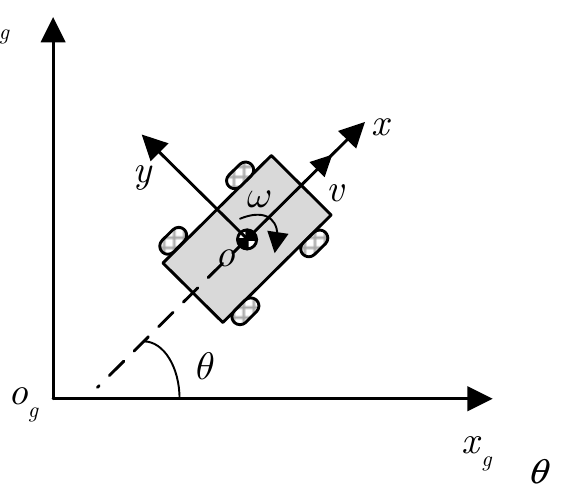
Figure 1. The four-wheel model and single-track model of the considered IWMD-MR. At the same time, the linear model reduces the amount of computation, convenient for the design of the controller and is conducive to the actual implementation. Furthermore, at the Taylor expansion for Equation (1) at the point ( χ r , u r ) , we have: